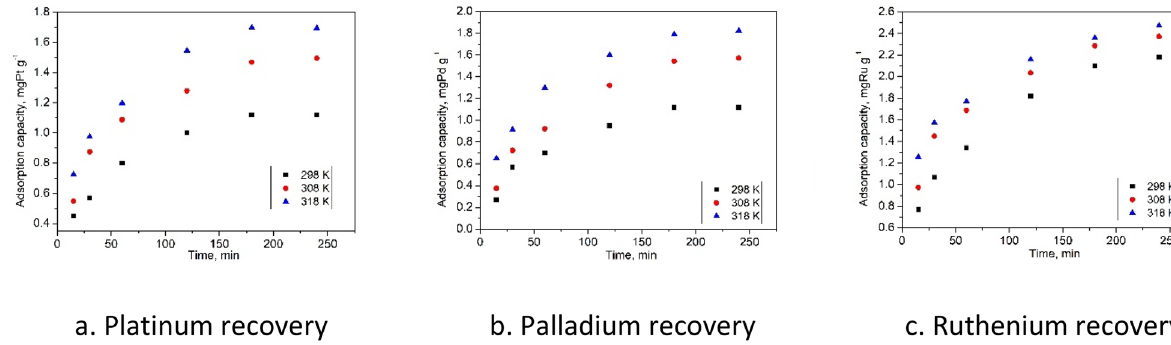
Figure 7. Contact time at different temperatures.